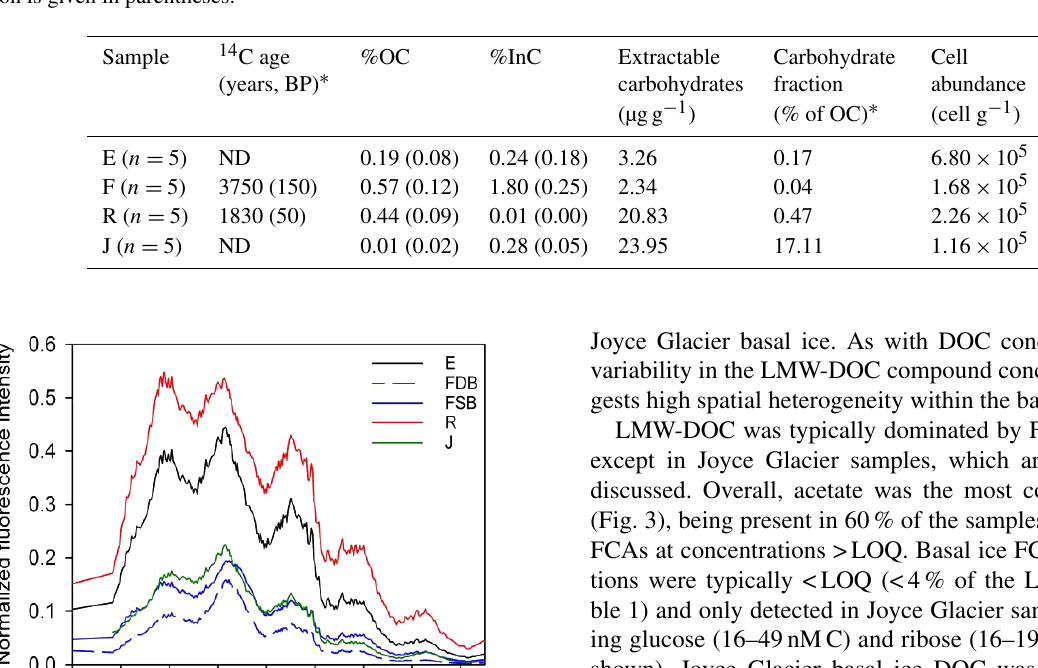
Table 2. Mean sediment characteristics. An asterisk indicates sediment OC age from Stibal et al. (2012), method described in the online supporting information. ND denotes not determined. E – Engabreen, F – Finsterwalderbreen, R – Russell Glacier, J – Joyce Glacier. Standard deviation is given in parentheses.